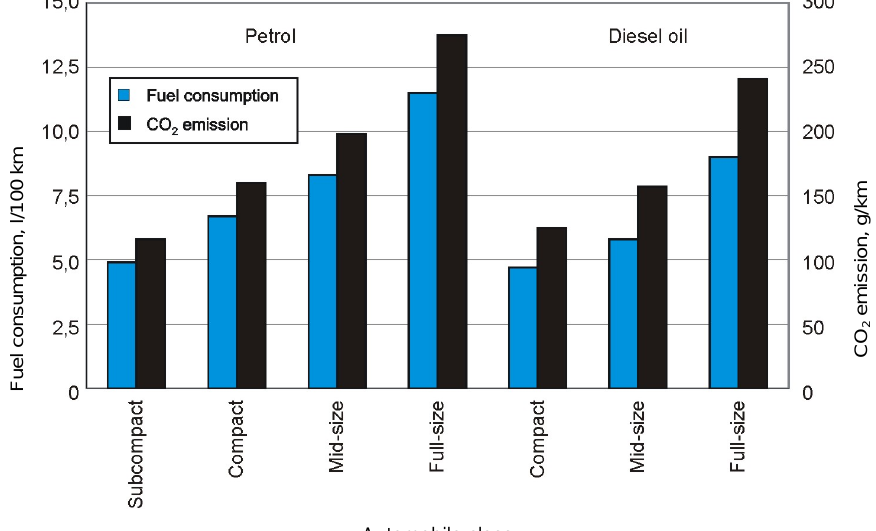
Fig 6. The relationship between average fuel consumption and CO 2 emission of an automobile and its